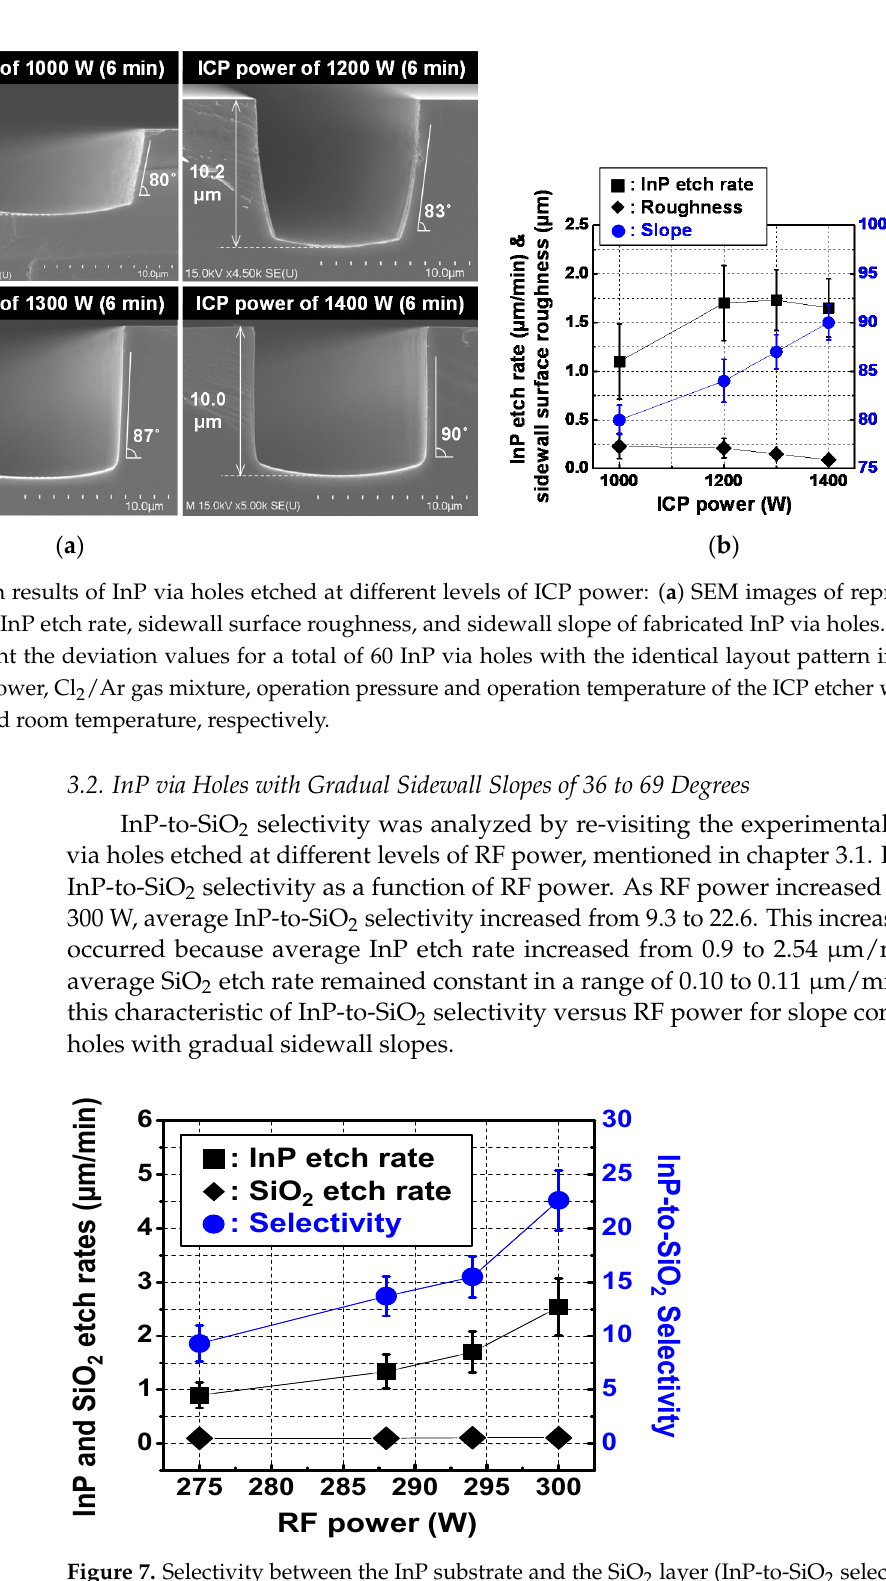
Figure 7. Selectivity between the InP substrate and the SiO 2 layer (InP-to-SiO 2 selectivity) of InP via holes etched at different levels of RF power. Error bars represent the deviation values for a total of 60 InP via holes with the identical layout pattern in the three fabrication lots. Table 1. Specific process flow and measured results for the SiO 2 layer with small sidewall slopes. Process Flow /Measurement